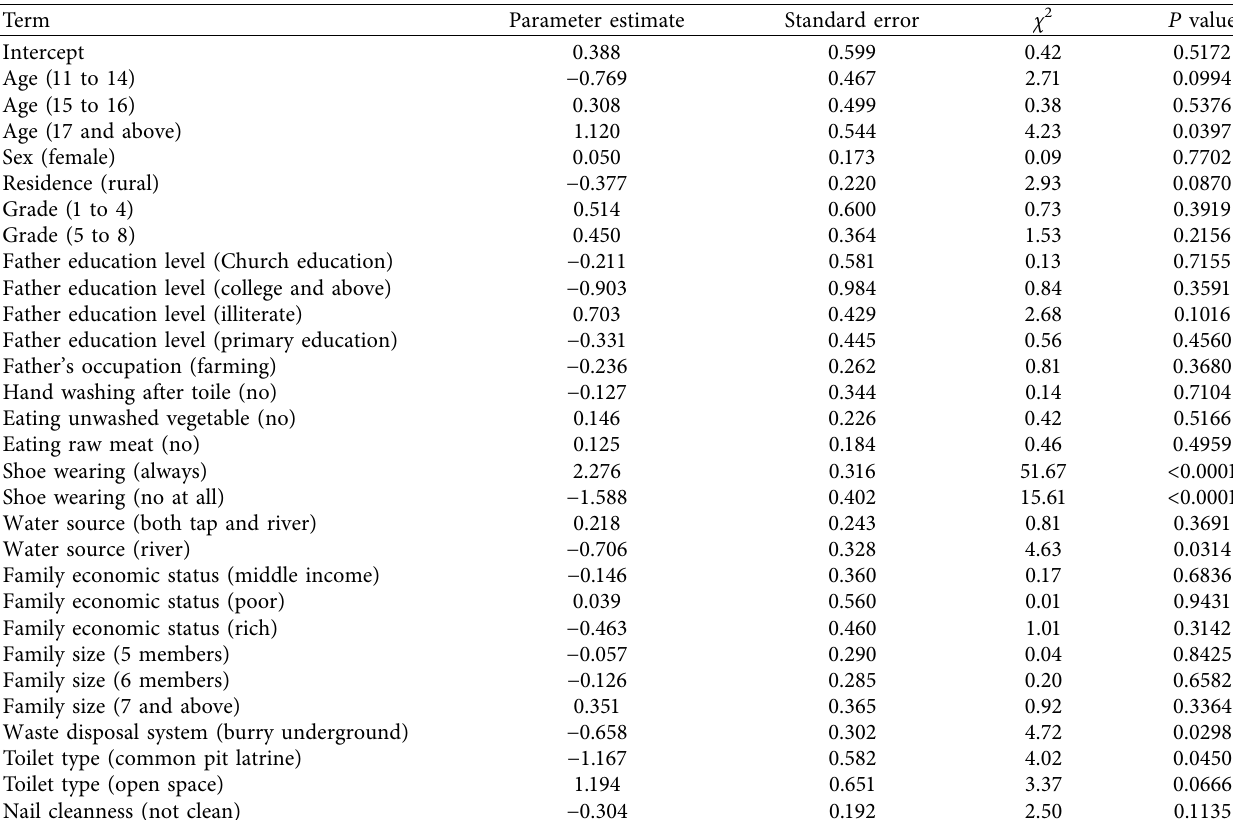
Table 6: Relationship between explanatory variables and soil-transmitted helminthic infections among school children in Jaragedo town, South Gondar Zone,